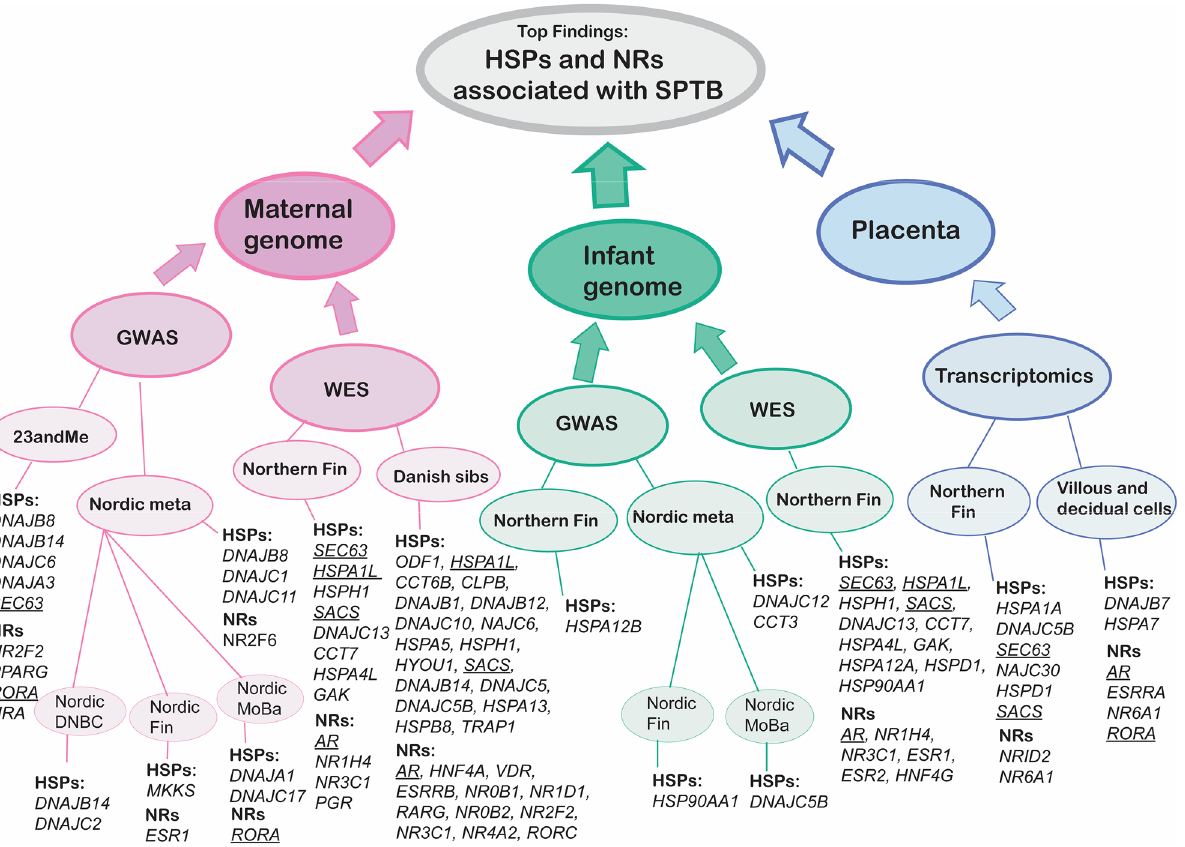
Figure 2. Top findings of HSPs and NRs associated with SPTB. Several datasets supported roles for SEC63 , HSPA1L , SACS , RORA , and AR in susceptibility to SPTB. These genes are underlined in the